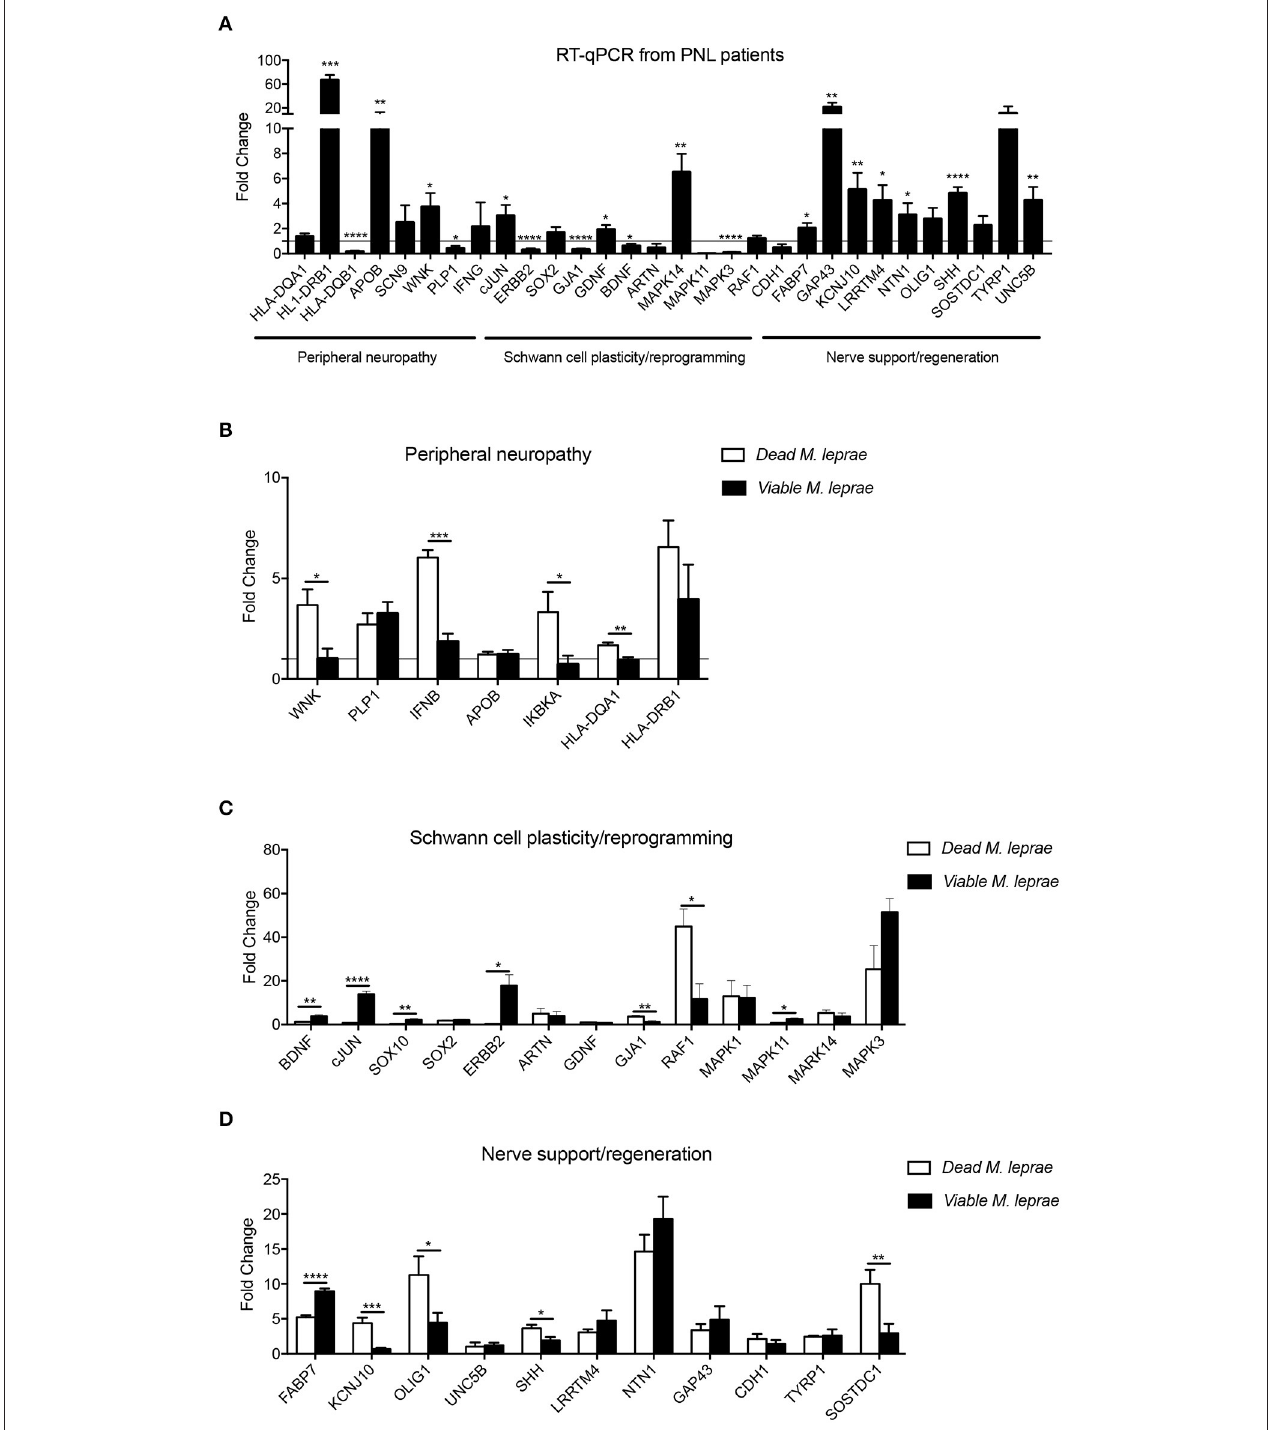
FIGURE 1 | Expression pattern of genes involved in Schwann cell biology. Gene expression profile analysis of upregulated and downregulated mRNA transcripts from signaling pathways related to peripheral neuropathy, Schwann cell plasticity and regeneration support. Analysis were performed in human nerve biopsies from leprosy ( A , black bars) and non-leprosy individuals ( A , horizontal line) and in human Schwann cells (B-D) infected with dead M. leprae (white bars) and viable M. leprae (black bars); results are presented as mean ± SD from three to eight normalized independent biological replicates; * p < 0.05, ** p < 0.01, *** p < 0.001, **** p < 0.0001.